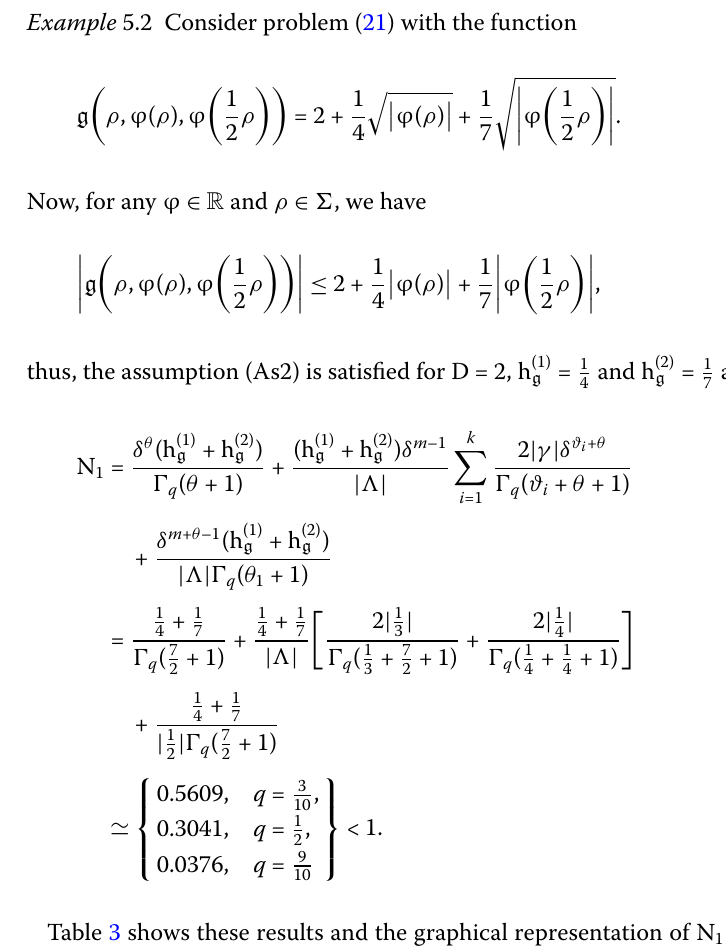
Example 5.2 Consider problem (21) with the